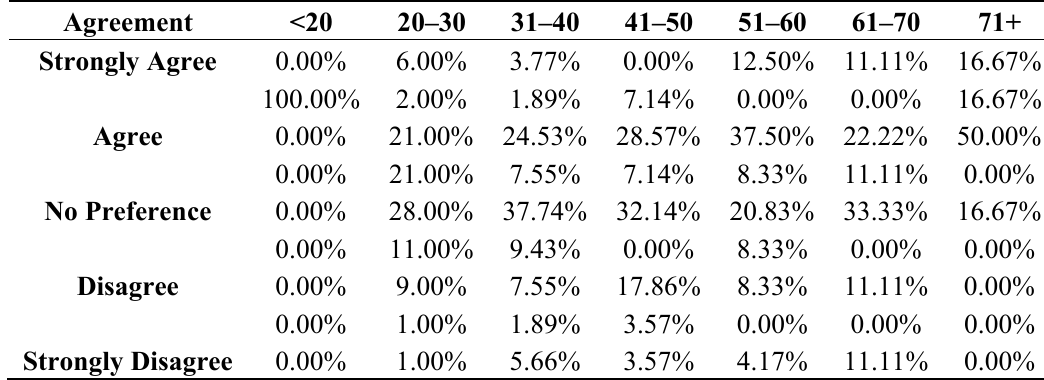
Figure 16. Graph of correlation between age and the statement “As an editor for a journal, I would publish an article with computer-generated findings”.